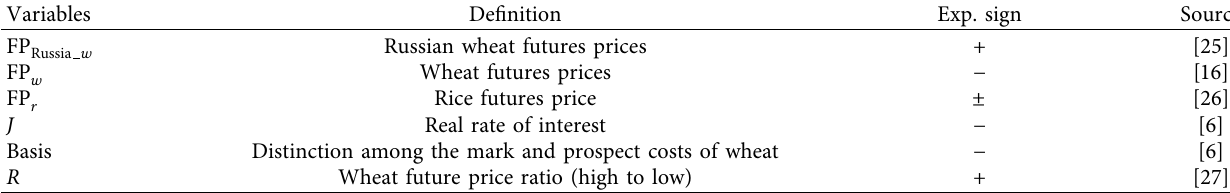
Table 1: Explanation of variables with expected sign and sources.